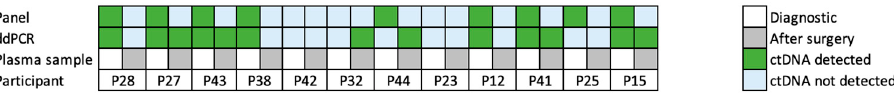
Table 3. Longitudinal cell-free DNA analysis using ddPCR, including input volumes.